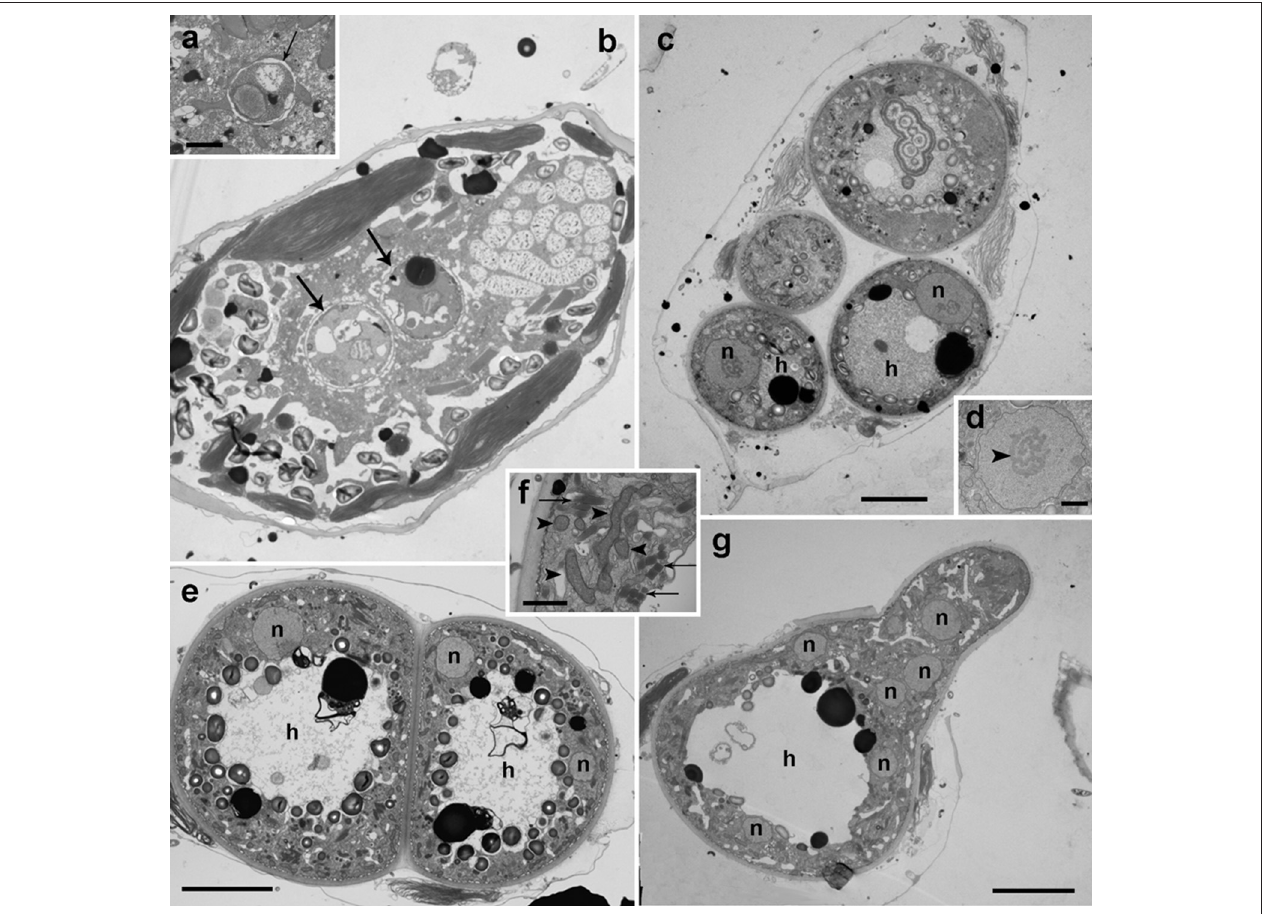
FIGURE 3 | Transmission electron microscopy micrographs showing the life-cycle stages from early infections to early sporocyte of Dinovorax pyriformis infecting Prorocentrum micans . (a) Detail of early infection stage of D. pyriformis located inside the parasitophorous vacuole (arrow) at the host cytoplasm. (b) Two early trophonts (arrows) infecting a P. micans cell. (c) Four trophonts after having completely consumed all of the host cytoplasm, showing a large nucleus (n) and central hyaline material (h). (d) Detail of the nucleus of the trophont. The nucleolus can be observed (arrowhead). (e) Two early sporocytes growing in contact. Two nuclei can be observed in a single sporocyte at this stage (n) and the central hyaline material (h). (f) Detail of the cytoplasm with all organelles like mitochondria (arrowheads) and trichocysts (arrows) accumulated at the periphery. (g) Early sporocyte forming the germ-tube. Several nuclei (n) can be observed. The central area is occupied by hyaline material (h). All scale bars = 5 µ m, except (a,d,f) = 1 µ